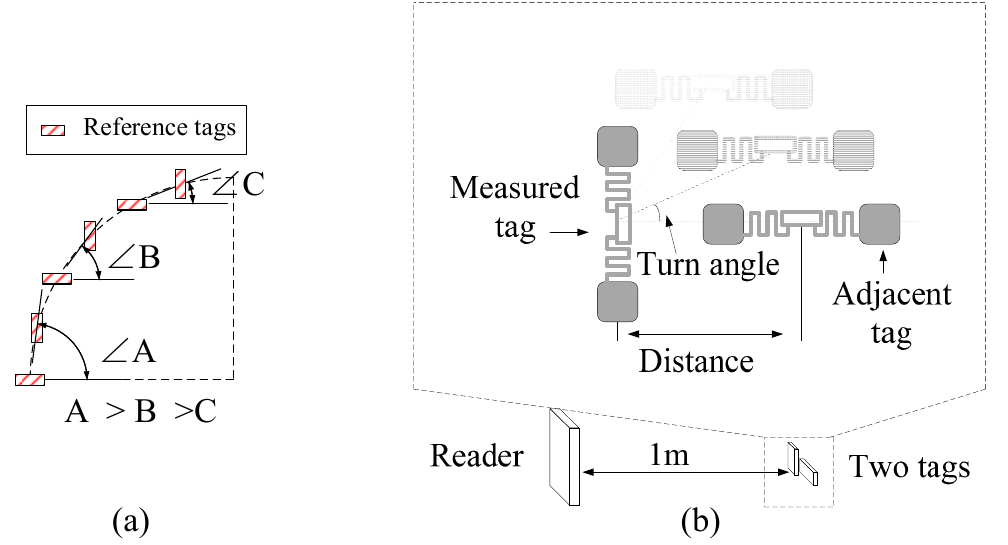
Figure 3. Analyses of mutual coupling: ( a ) part of UCA using perpendicularly placed tags and ( b ) measurement setup.